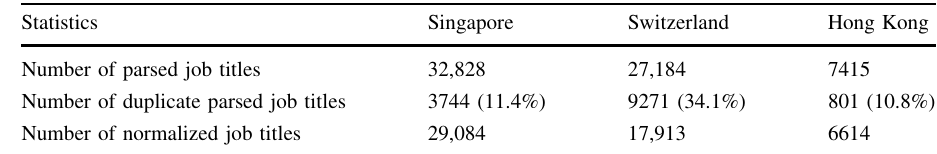
Table 3 Statistics of normalized job titles (min_sup (cid:3) 10)